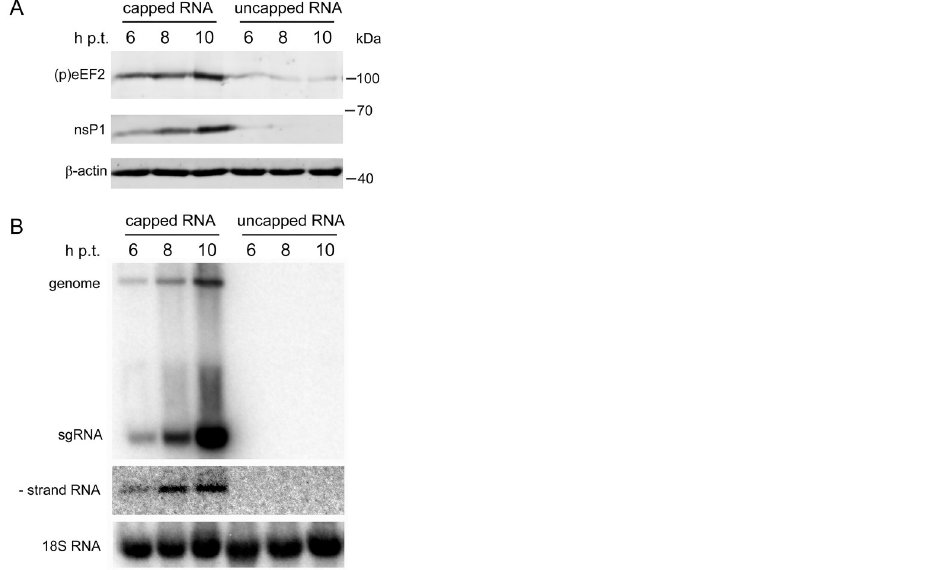
Fig 4. Transfection of a capped CHIKV replicon triggers eEF2 phosphorylation. BHK-21 cells were electroporated with in vitro transcribed capped or uncapped CHIKV LS3 replicon RNA. Protein lysates were harvested and RNA was isolated at 6, 8 and 10 h p.i. ( A ) Viral protein nsP1 and (p)eEF2 (T56) were detected by WB. ( B ) Positive- and negative strands of CHIKV RNA were detected by in-gel hybridization with radioactively labeled oligonucleotides complementary to the 3’ end of either negative- or positive-strand CHIKV RNA. The cellular 18S ribosomal RNA was used as a loading control. Figures are representative of two independent replicates.